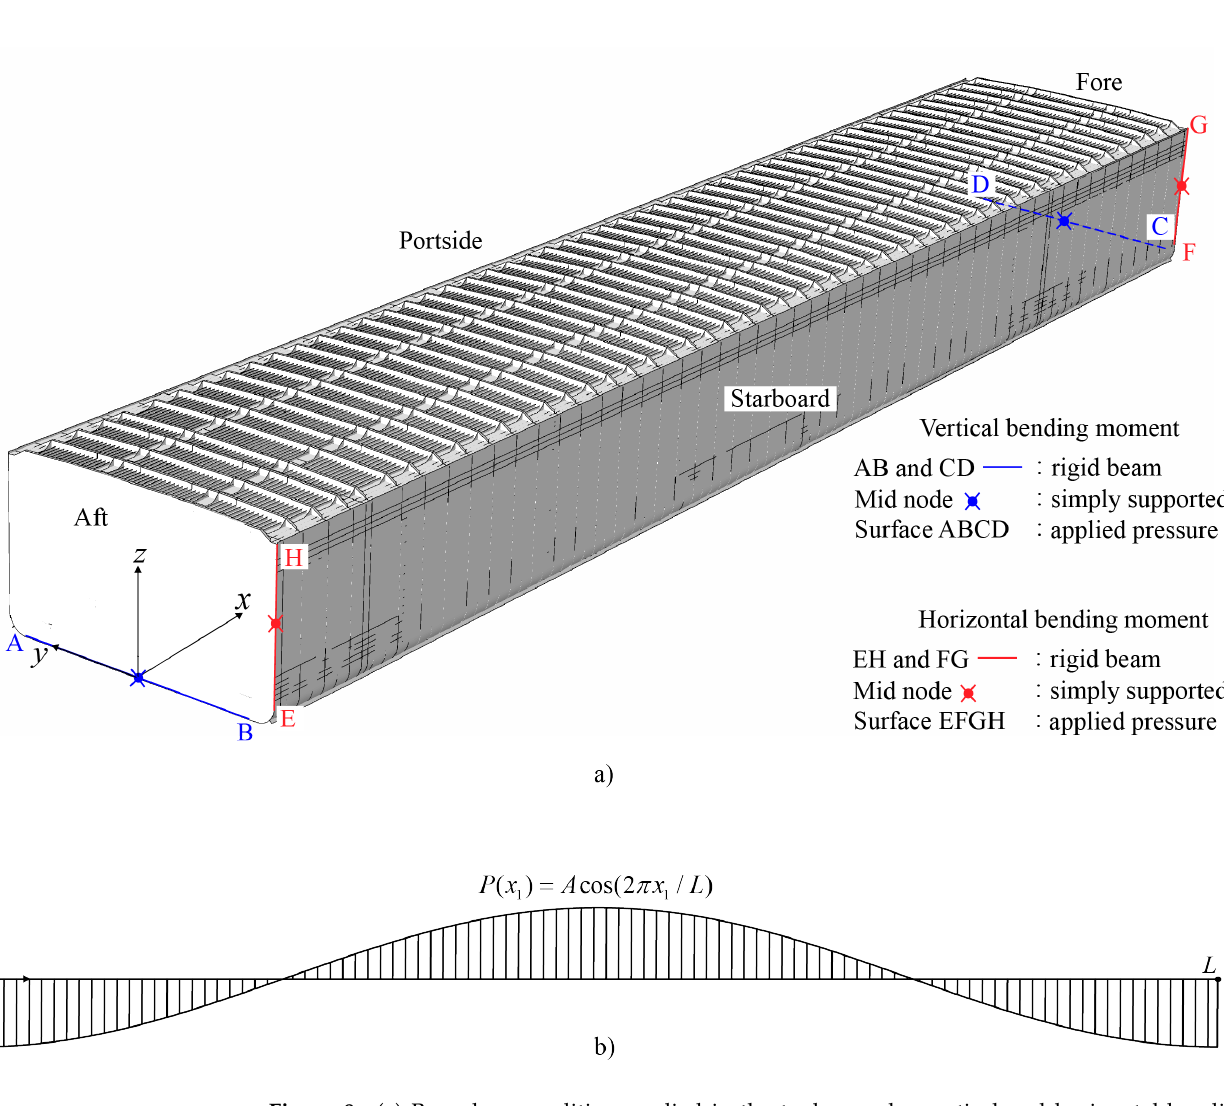
Figure 8. ( a ) Boundary condition applied in the tanker under vertical and horizontal bending moments. ( b ) Distributed pressure applied on the